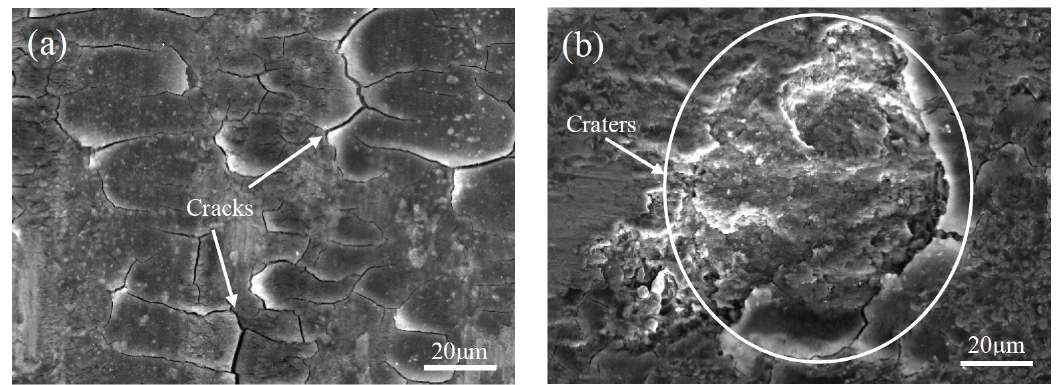
Figure 14. Two typical defect features on the tribolayer: (a) Network cracks and (b) craters.